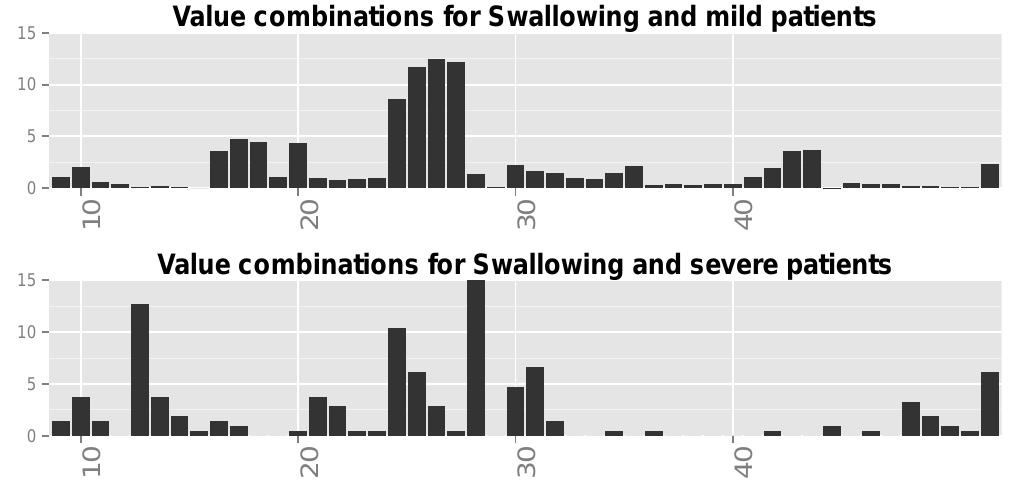
Figure 12. Distributions over all possible (64) value combinations of the four important variables for Swallowing for ( top ) mild patients and ( bottom ) severe patients. Numbers along the x -axis are indices of the